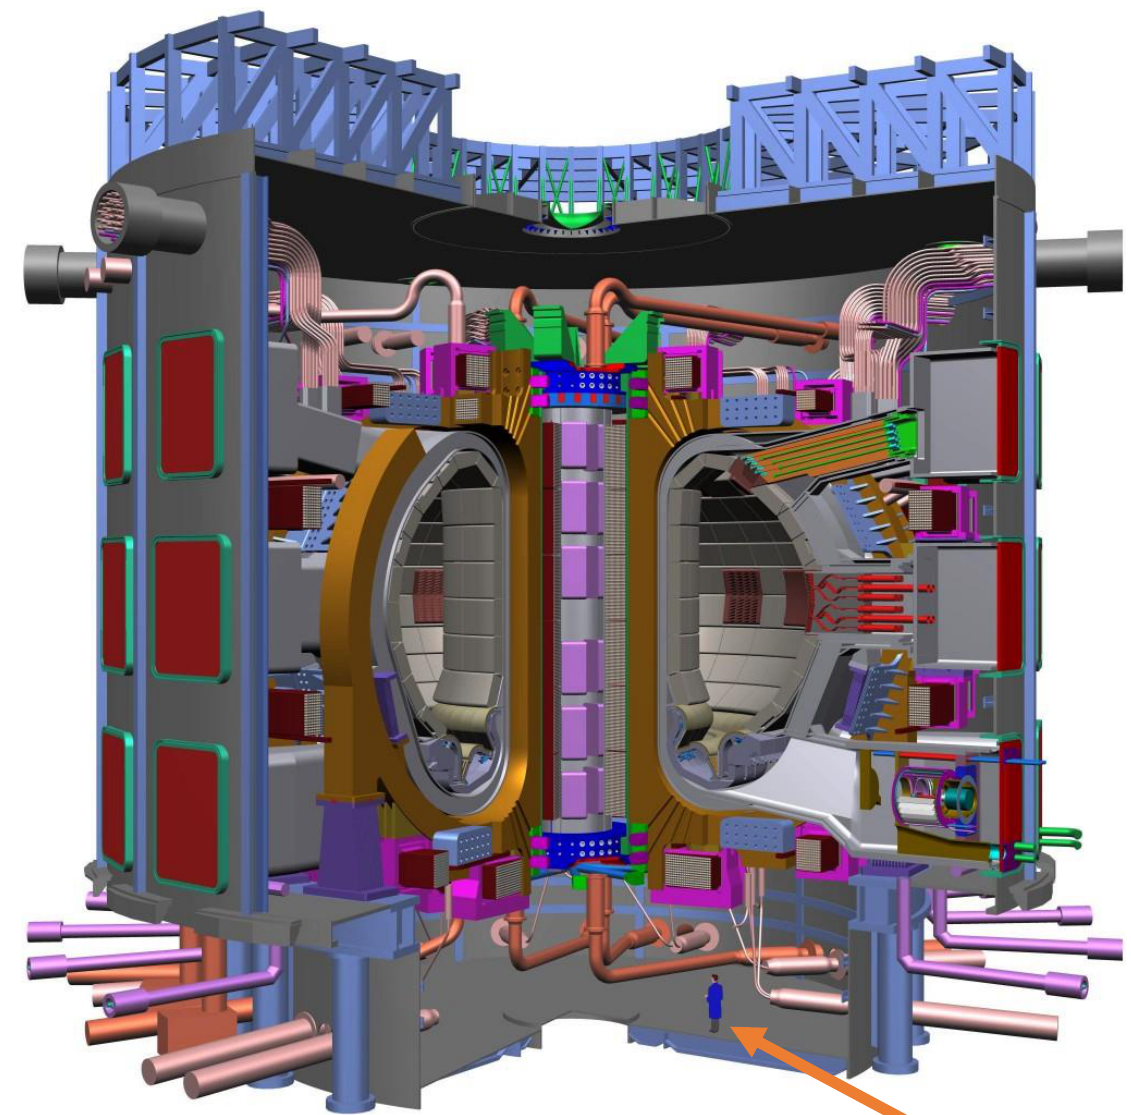
Figure 3. Cutaway view of the ITER fusion reactor (from ITER Technical Basis [4]). Note the size of the device in comparison with the human figure. © 2002 IAEA.